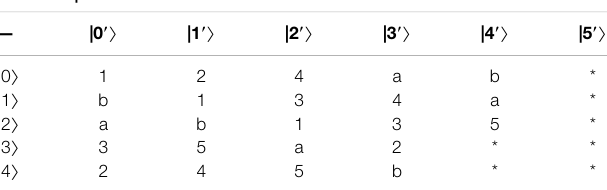
TABLE 9 | 5×3+2×4=23-member.